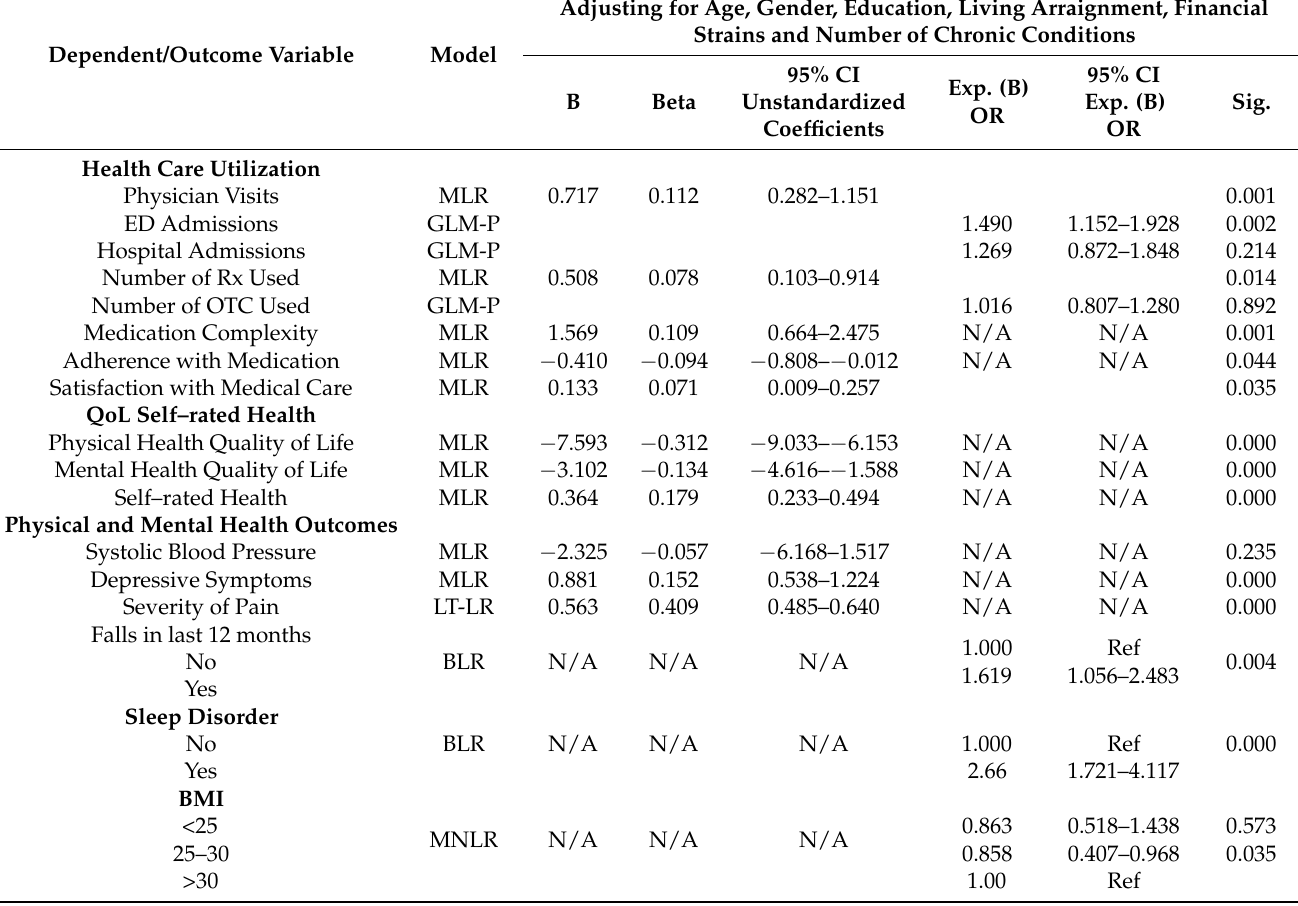
Table 2. Multivariate analysis of associations between chronic low back pain and outcome variables.